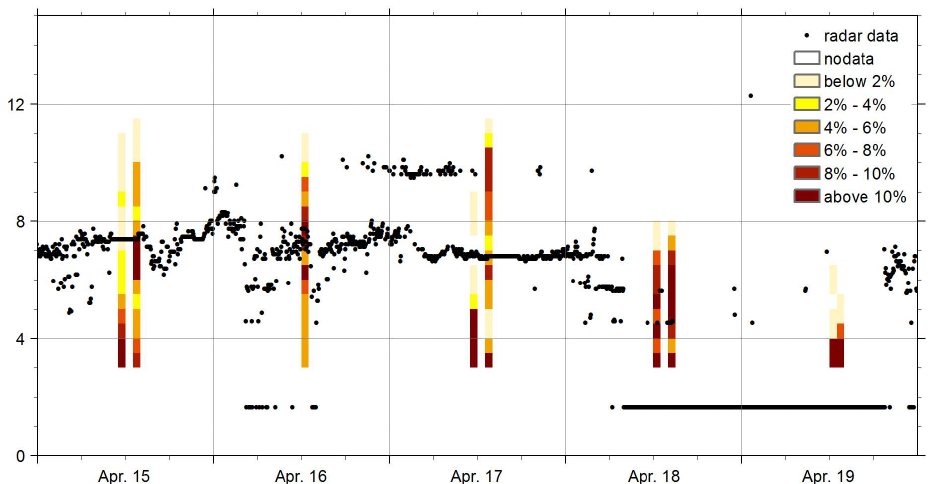
Fig. 9. Vertical distribution of ACTH for the period between 15 and 19 April. All pixels are classified according to their ACTH in one of the 500m height classes. Colours represent the relative amount of pixels within a class (in percent) – dark colours show that there are many pixels in a height class. Because of two daytime MODIS overpasses, two ACTH estimations can be processed per day. On 16 April only one estimate is presented because of the unfavourable satellite’s swath characteristics. The highest measured heights by a radar located at Keflavik airport (Marzano et al., 2011) are shown for the comparison. Please note that the radar height only reflects the eruption column height near the vent (e.g. at max 100km away from the vent) and our ACTH cover the whole North Atlantic